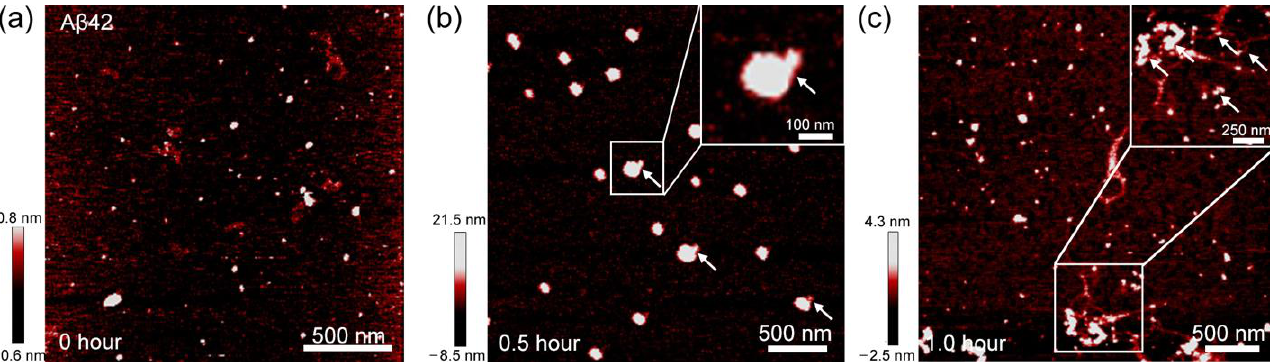
Figure 3. AFM images of Aβ40 aggregates that are made under the incubation time of (a) 0 h, (b) 1 h, (c) 24 h, (d) 30 h, (e) 36 h, and (f) 48 h, respectively. The white arrows indicate two large particles with similar radius are fusing together.